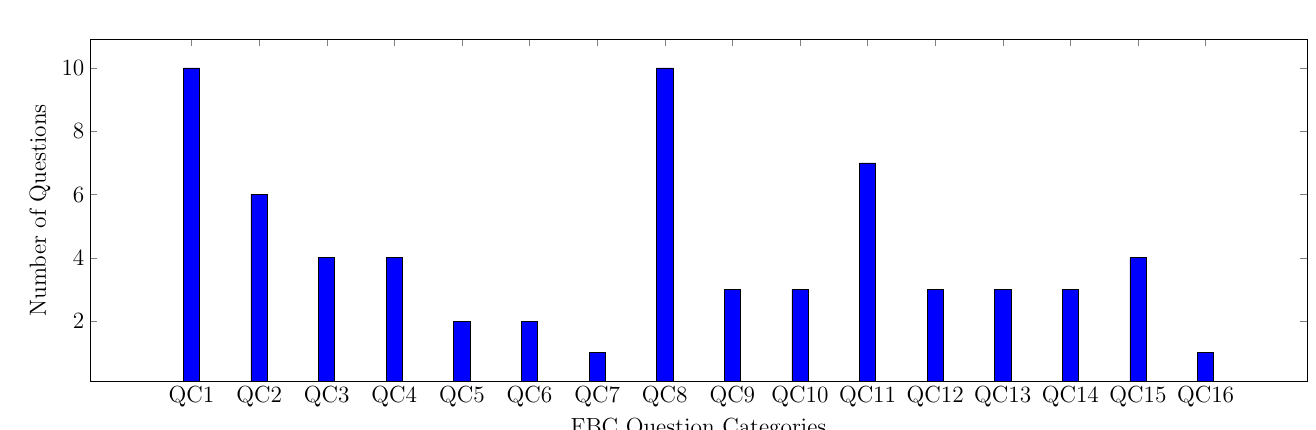
Figure 2. Statistical chart of questions’ topic categorical